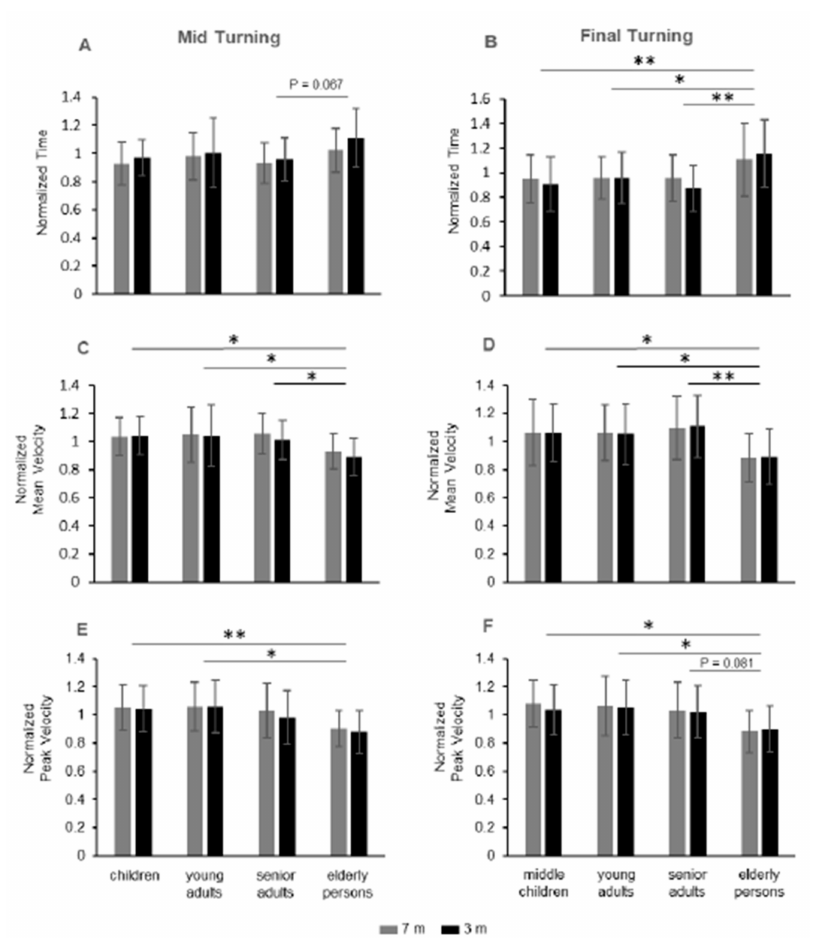
Figure 3. Duration and velocity in the turning phases of 7 and 3 m TUG. Non-dimensional normalized data of the four groups for the time in mid turning ( A ) and in final turning ( B ), for the mean velocity in mid turning ( C ) and final turning ( D ), and for the peak velocity in mid turning ( E ) and final turning ( F ). * p < 0.05; ** p <